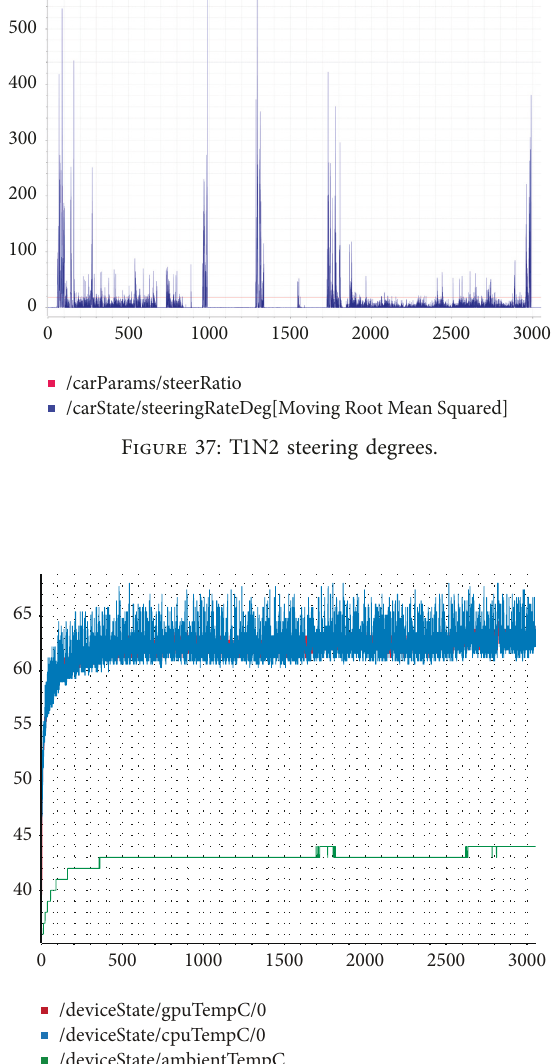
Figure 38: T1N2 temperatures.